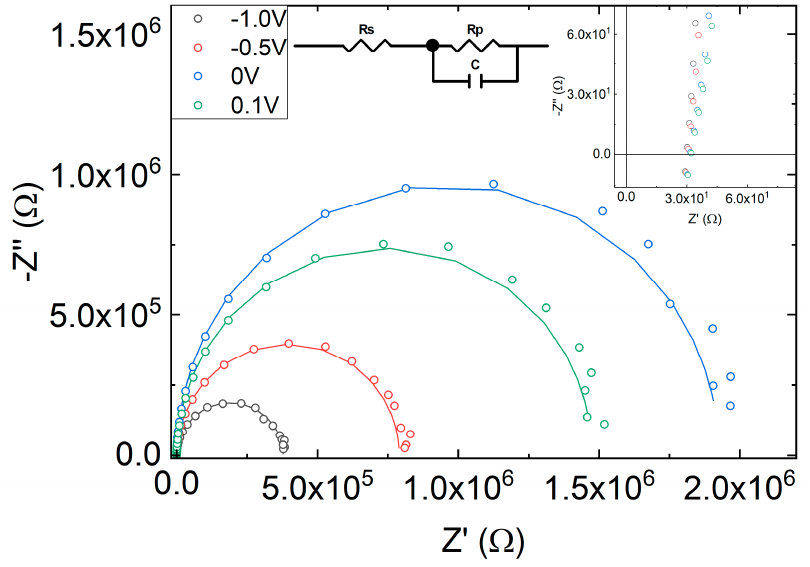
Figure 8. Cole-Cole diagram in dark at different bias (symbols). Solid lines show the fit to the circuit in the inset. The upper right inset shows the high frequency part (the bottom-left of Cole-Cole plot).